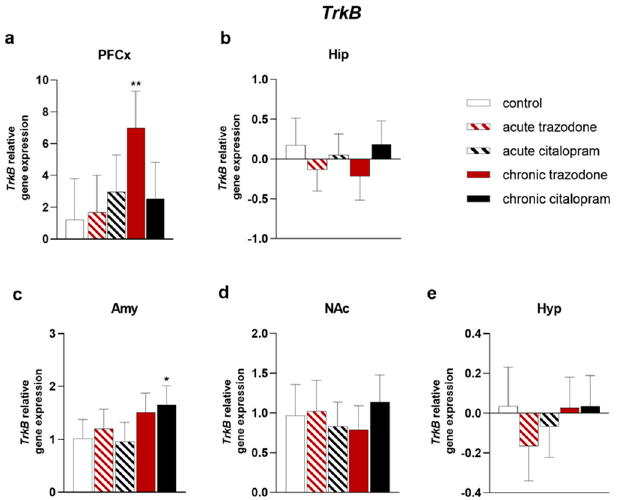
Figure 2. mRNA levels of TrkB in the PFCx ( a ), Hip ( b ), Amy ( c ), Nac ( d ), and Hyp ( e ) after acute or chronic treatment with trazodone, citalopram, or vehicle. The least square predicted means with 95% confidence intervals are plotted. Data were log-transformed when required to stabilise the variance and satisfy the parametric assumptions ( b , e ). **: p < 0.01; *: p < 0.05 in the Planned Comparison vs. control. n = 6/group.